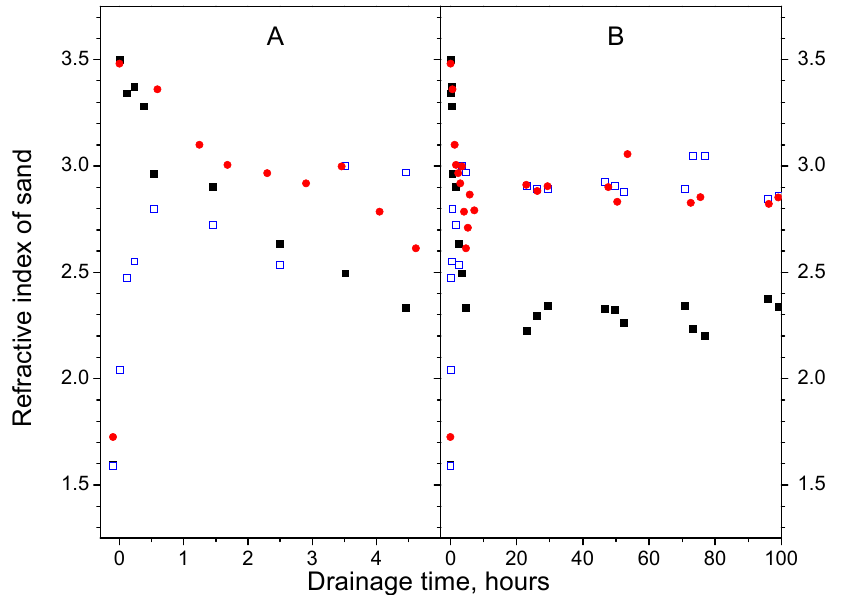
Figure 5. Dependence of the sand refractive index on the water drainage time on narrow ( A ) and wide ( B ) time intervals. Calculation by Equation (5): black squares ■ —experiment 1; red circles ● — experiment 2. Calculation by Equation (8): blue empty squares □ —experiment 1).